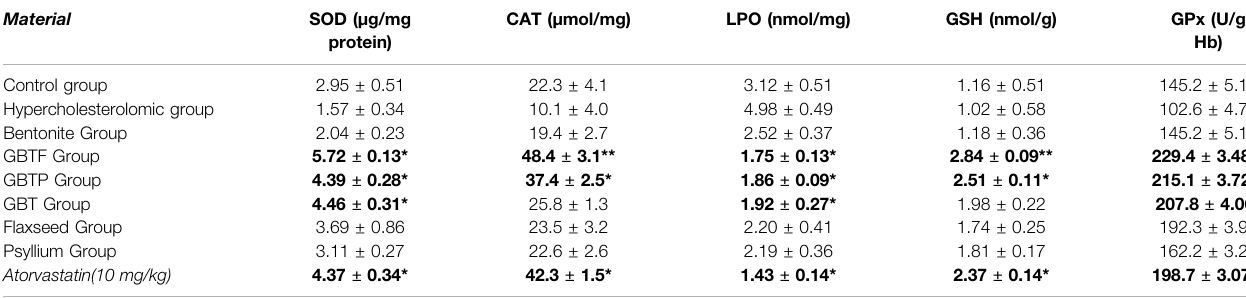
TABLE 5 | Effects of test materials on SOD, CAT, LPO, GSH and GPx levels.